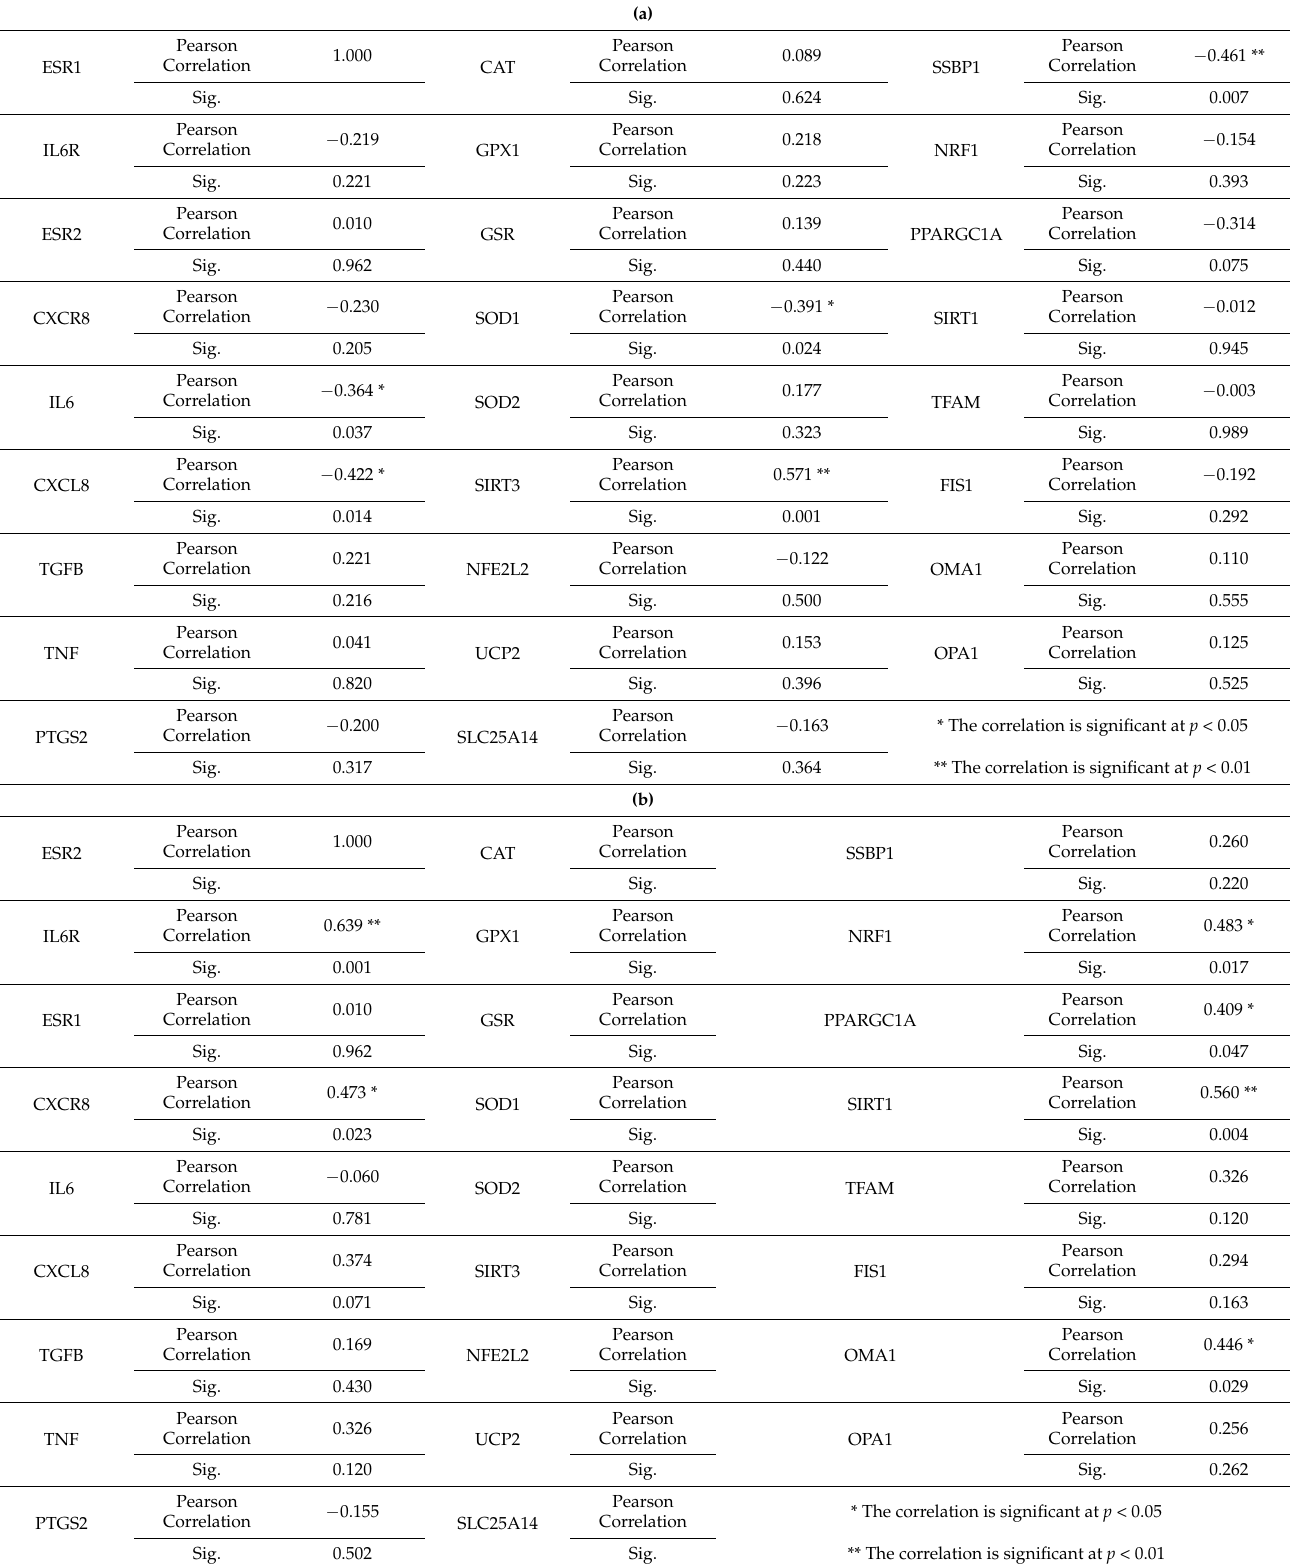
Table 6. Correlation values of estrogen receptors subtype alpha and beta gene expression in breast tumors. ( a ) ESR1 correlation. ( b ) ESR2